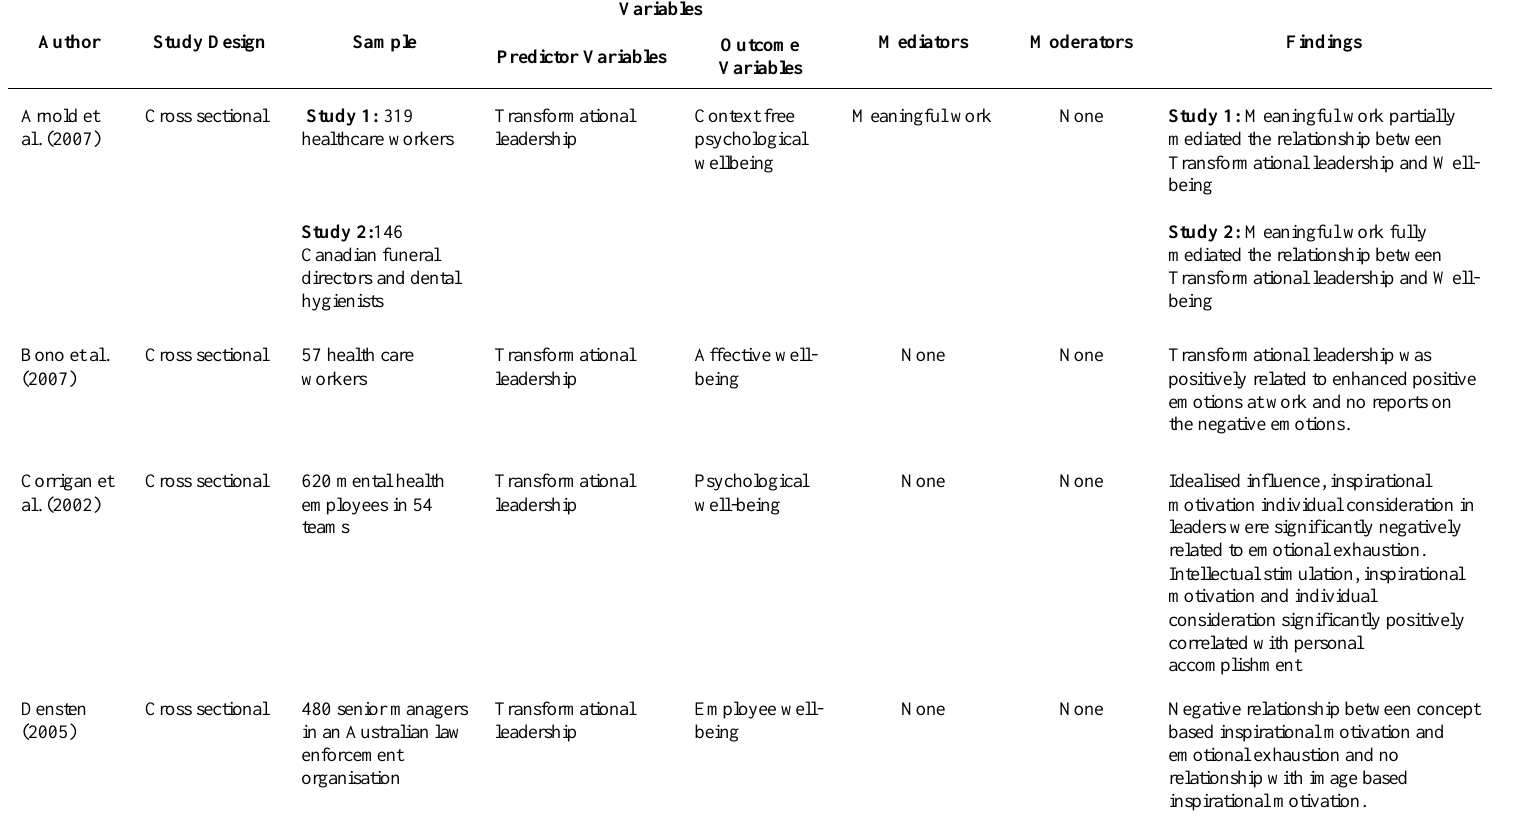
Table 1: Extraction Table